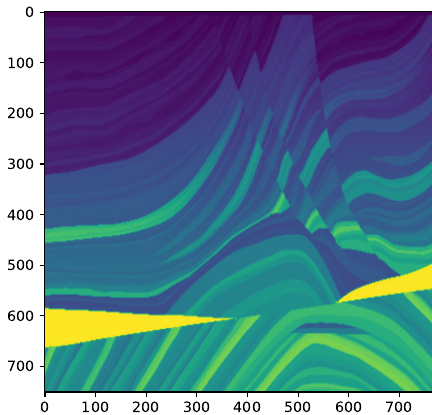
Figure 1. The landscape of the seismic wave propagation. Different colors in the model represent different media which impact the speed of wave